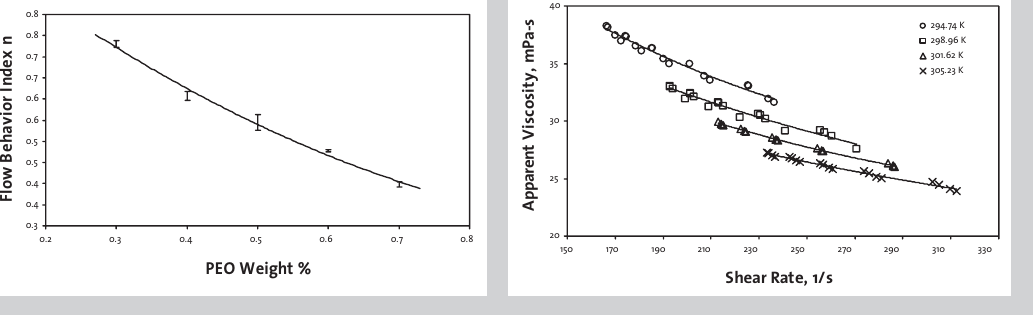
Figure 10 (left): Flow behavior index versus PEO weight % in aqueous solutions at 298.99 K, using quadruple experimental data. Figure 11 (right): Apparent viscosity versus shear rate for the 0.5 wt% PEO aqueous solution at 294 - 306 K. Table 2: Average dynamic viscosity (DV) values of quintuple experimental DV values, their standard deviations (SDs) and percentages of SDs, and error % of average experimental DV values in comparison of the literature DV value 41.7 mPa·s of 60- w% sucrose aqueous solu- tion at 299.15 K. Table 3: Average quadruple left- hand side (LHS) values of non-Newtonian viscosity equation (NNVE), and their standard deviations (SDs) and percentages of stan- dard deviations for average LHS values with 0.5 wt% PEO aqueous solution. Table 4: Average flow behavior indexes of 0.5 wt% PEO aqueous solution at 294 - 306 K, using quadruple experimental data. Table 5: Average apparent viscosity values, and their standard deviations (SDs) and per- centages of standard devia- tions for quadruple experi- mental data of 0.5 wt% PEO aqueous solution at various average temperatures, and apparent viscosity values predicted from the Ahrre- nius equation. Table 6: Average flow behavior indexes of PEO aqueous solutions at the average temperature 298.99 K, using quadruple experimental